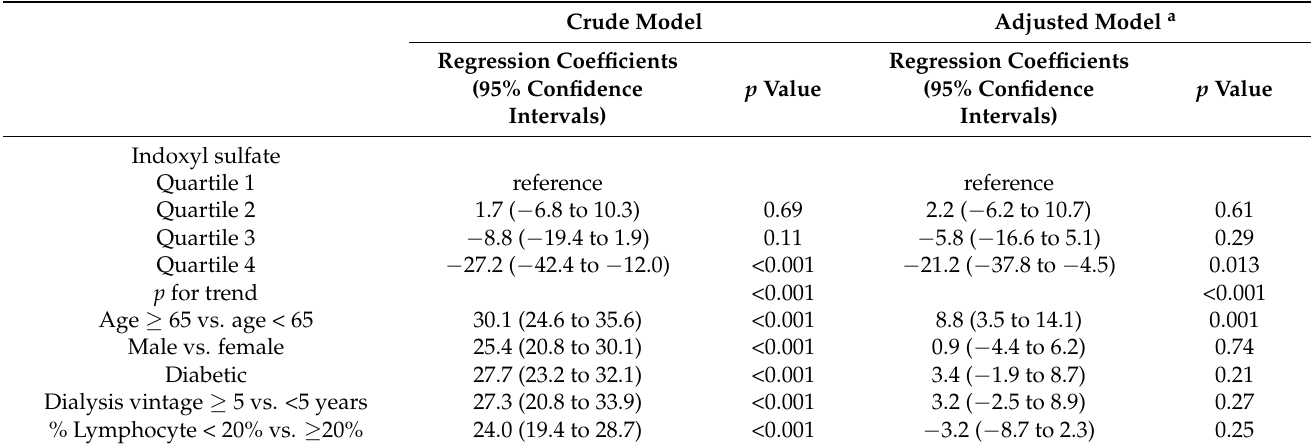
Table 3. Contributing factors in sVNT-measured neutralization at 4 weeks after administration of the 1st dose of the ChAdOx1 vaccine in patients undergoing hemodialysis. Crude Model Adjusted Model a Regression Coefficients Regression (95% Confidence Intervals)